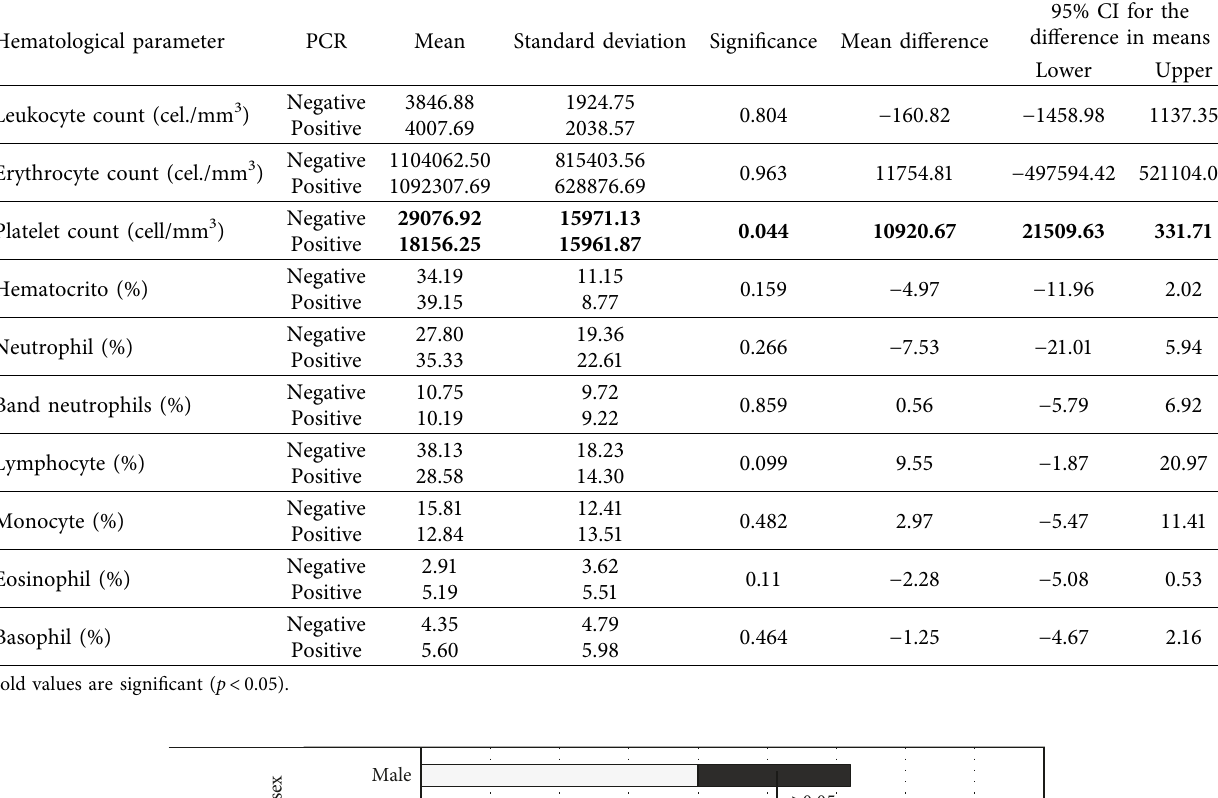
Table 2: Comparison of hematological parameters in canines according to the diagnosis of Leishmania spp.